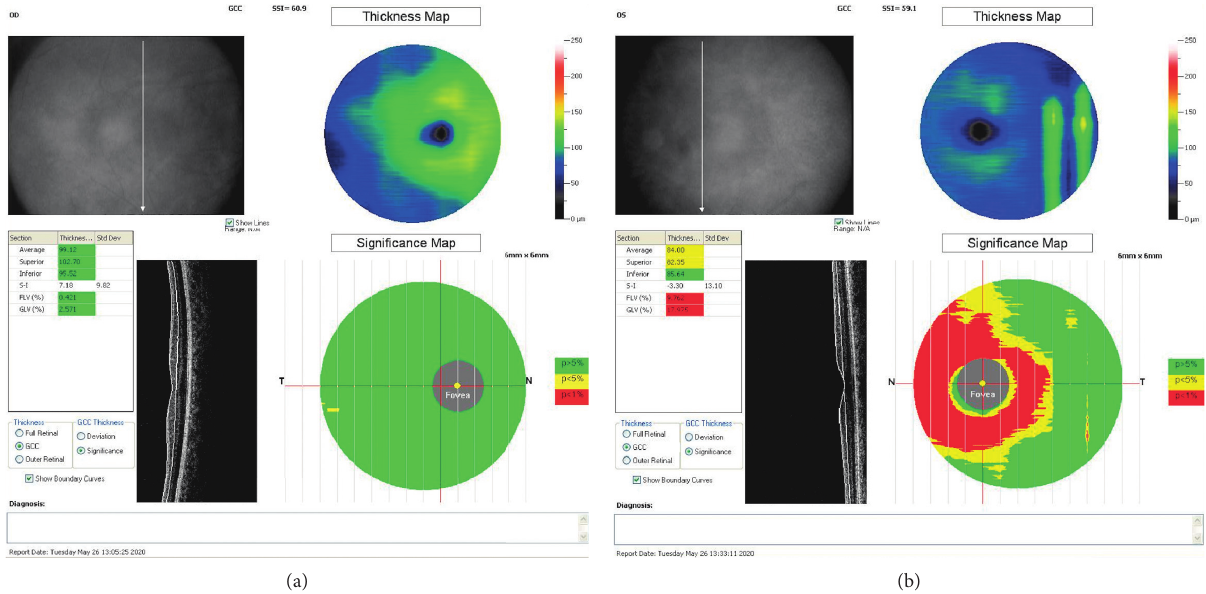
Figure 3: : Examples of OCTmeasurements of IIH and control patient matched by age. (a) Right eye GCC measurement of an individual of the control group, 29-year-old patient, with a GCC average thickness 99.12. (b) Left eye GCC measurement of an IIH, 53-year-old patient, with GCC average thickness